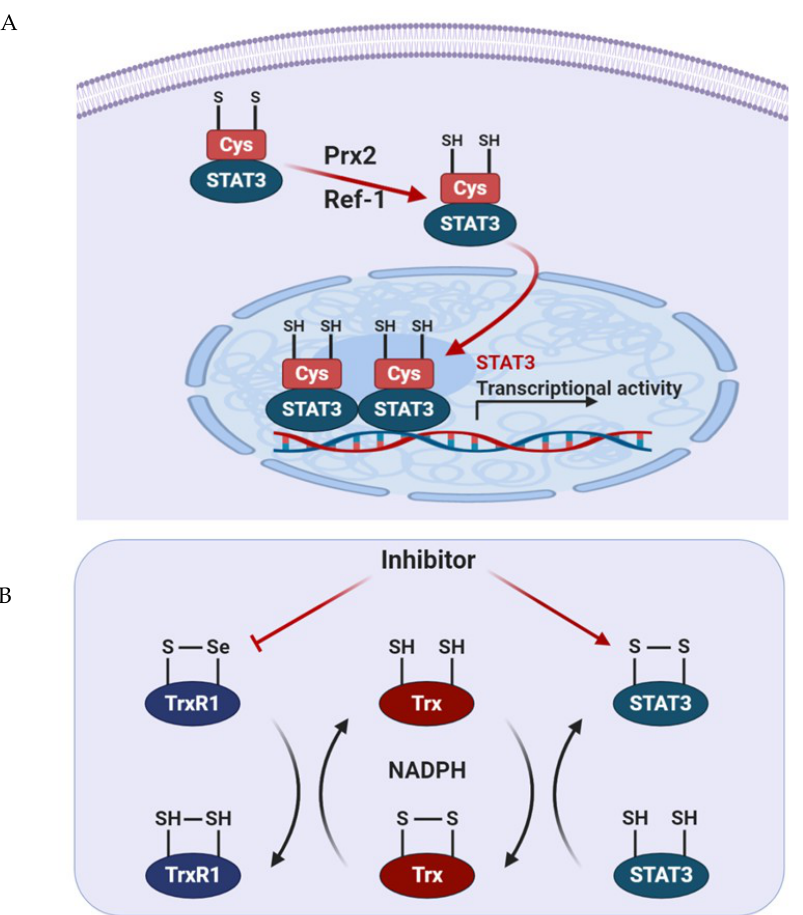
Figure 3. Intracellular signaling pathways modulating the redox status of STAT3. ( A ) Activation of Prx2 and Ref-1 results in the reduction of cysteine residues, thereby inducing transcription of STAT3. ( B ) Inhibition of TrxR1 results in the accumulation of oxidized STAT3, which blocks STAT3-dependent transcription.